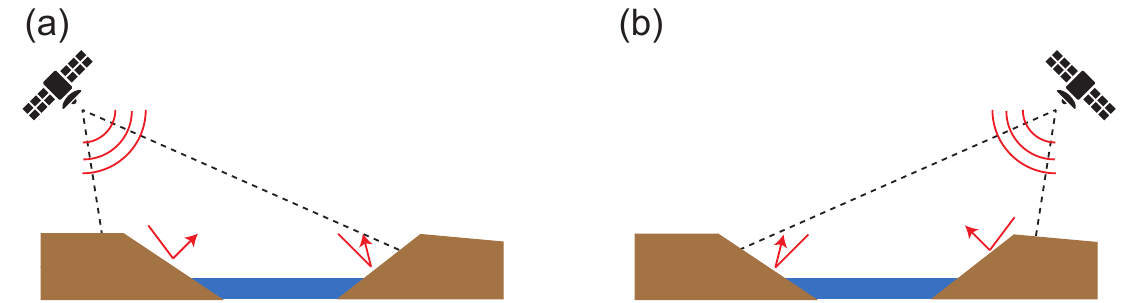
Figure 1. Schematic overview of differences in multipath images; ( a ) the left side and the right side of the shore show low and high intensities, respectively, and ( b ) the left side and the right side of the shore show high and low intensities, respectively.